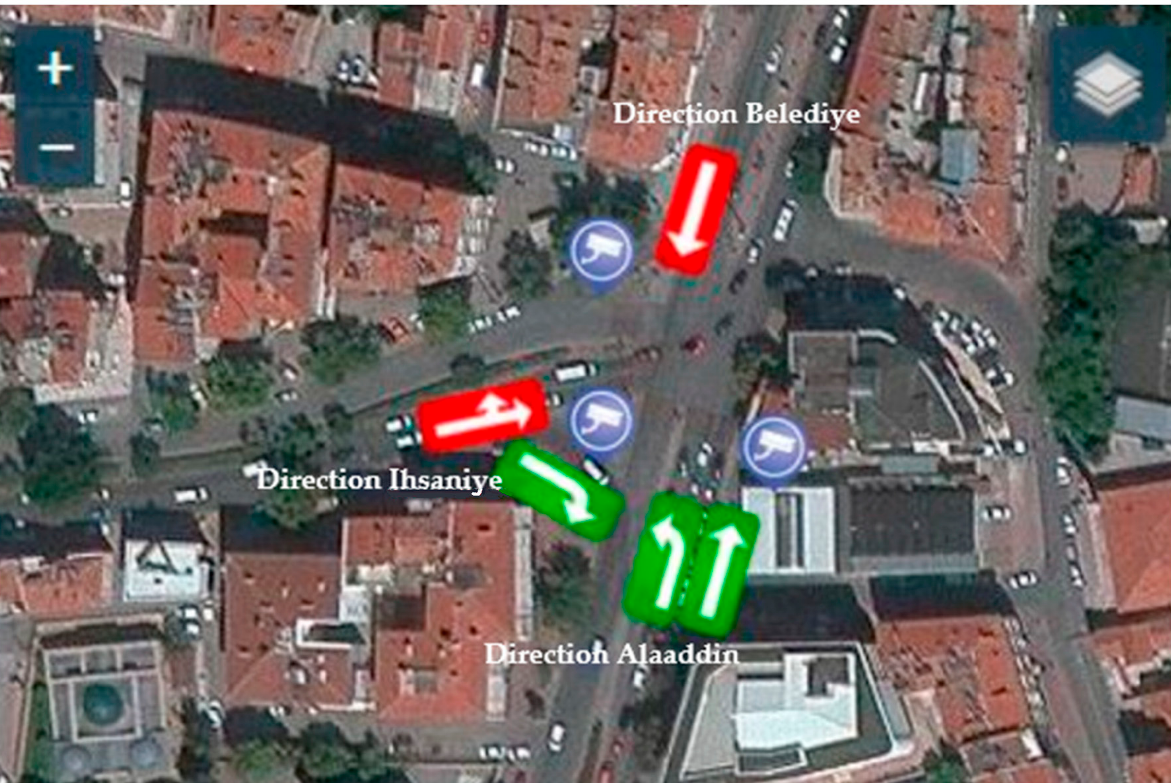
Figure 8. Junction view equipped with camera sensor (Konya/Turkey)